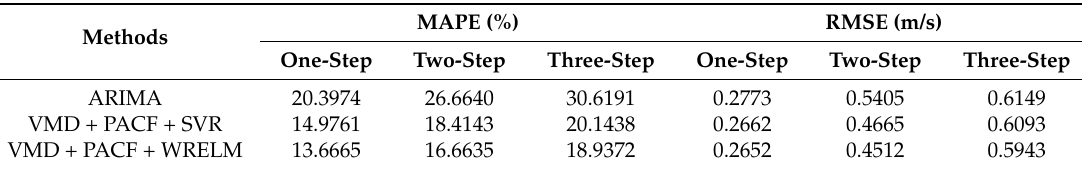
Figure 15. Forecasting results from 20–24 November 2004, using different methods. Table 6. The mean forecasting errors of different methods. Table 6. The mean forecasting errors of different